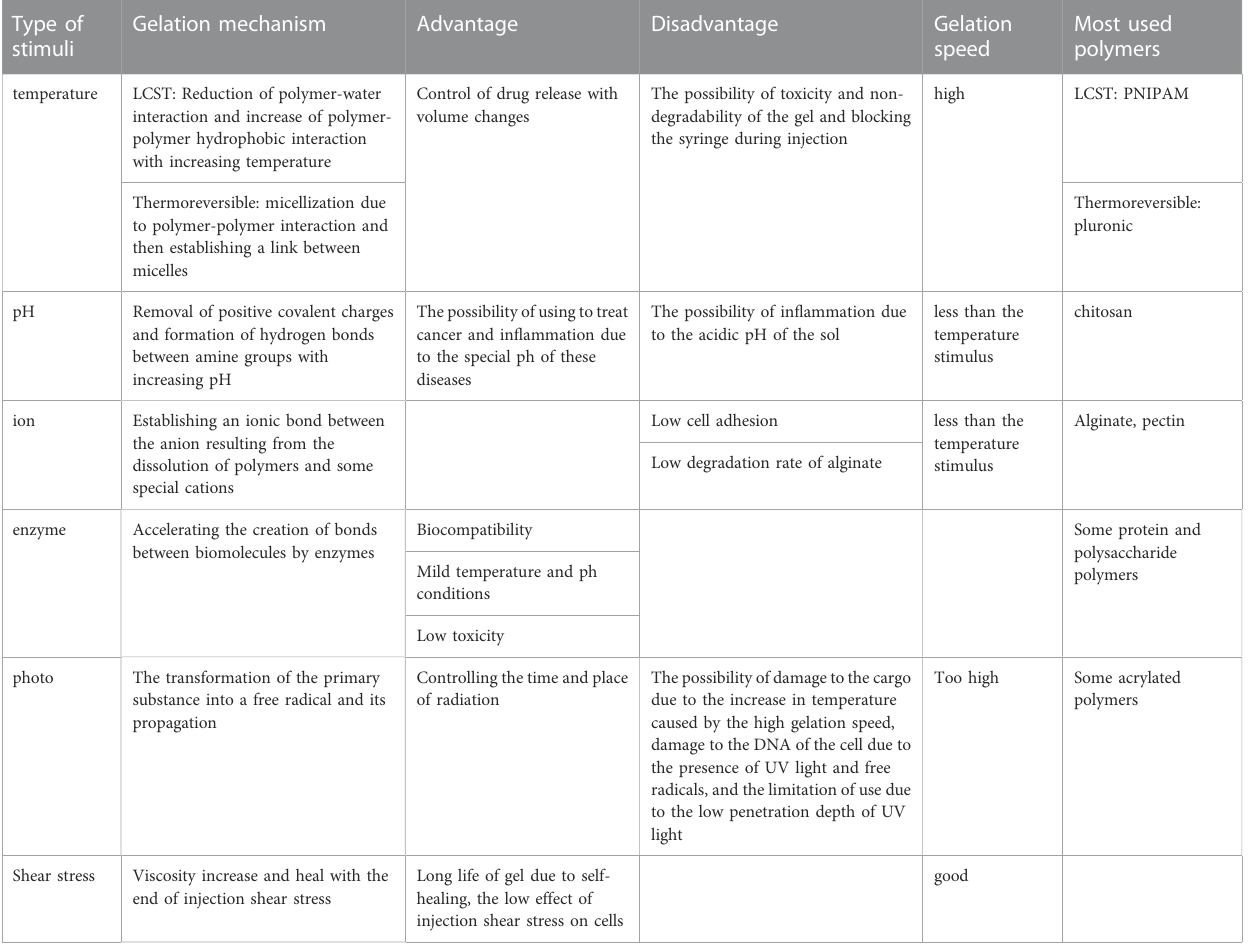
TABLE 2 A summary of the characteristics of the gels formed by the action of different